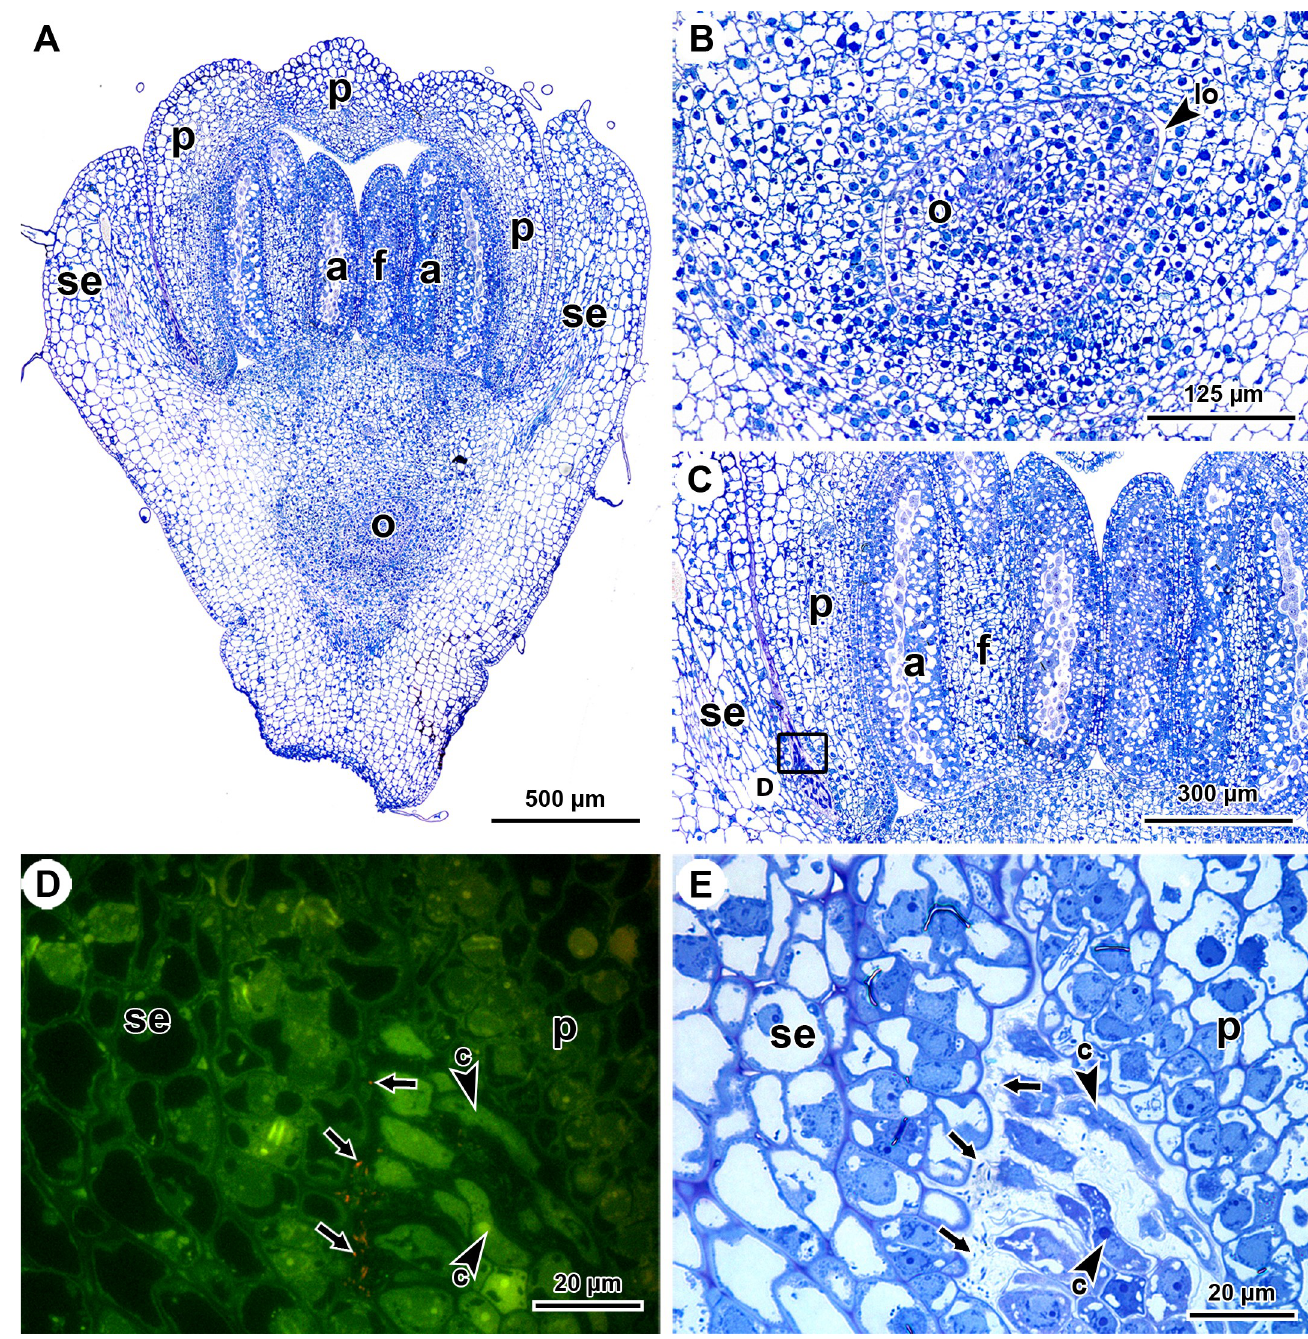
Fig 3. In situ detection of Burkholderia endophytes in longitudinal sections of P . punctata flower buds using FISH. (A) TBO-stained section through the flower bud. (B) Detail of (A) showing a locule with ovule. (C) Detail of (A) showing the absence of mucus between the anthers and the location of detail (D) between the sepals and petals. (D) Merged epifluorescence image of the space between the sepals and petals (C), showing FISH-labelled endophytes (red, arrows) between colleters. (E) Same detail as (D) stained with TBO after FISH labelling, visualising mucus between the bacteria and colleters. a, anthers; c, colleters; f, filament; lo, locule; o, ovule; p, petals; se,